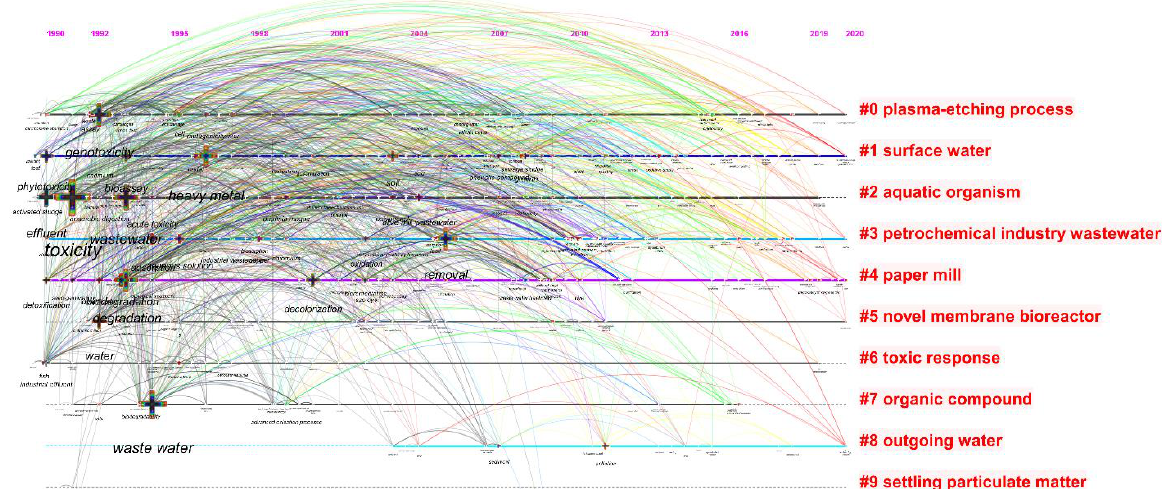
Figure 4. The timeline of the keywords appears in the scientific documents published in the field of industrial effluent and sludge toxicity from 1950 to 2020 via the utilization of CiteSpace software.